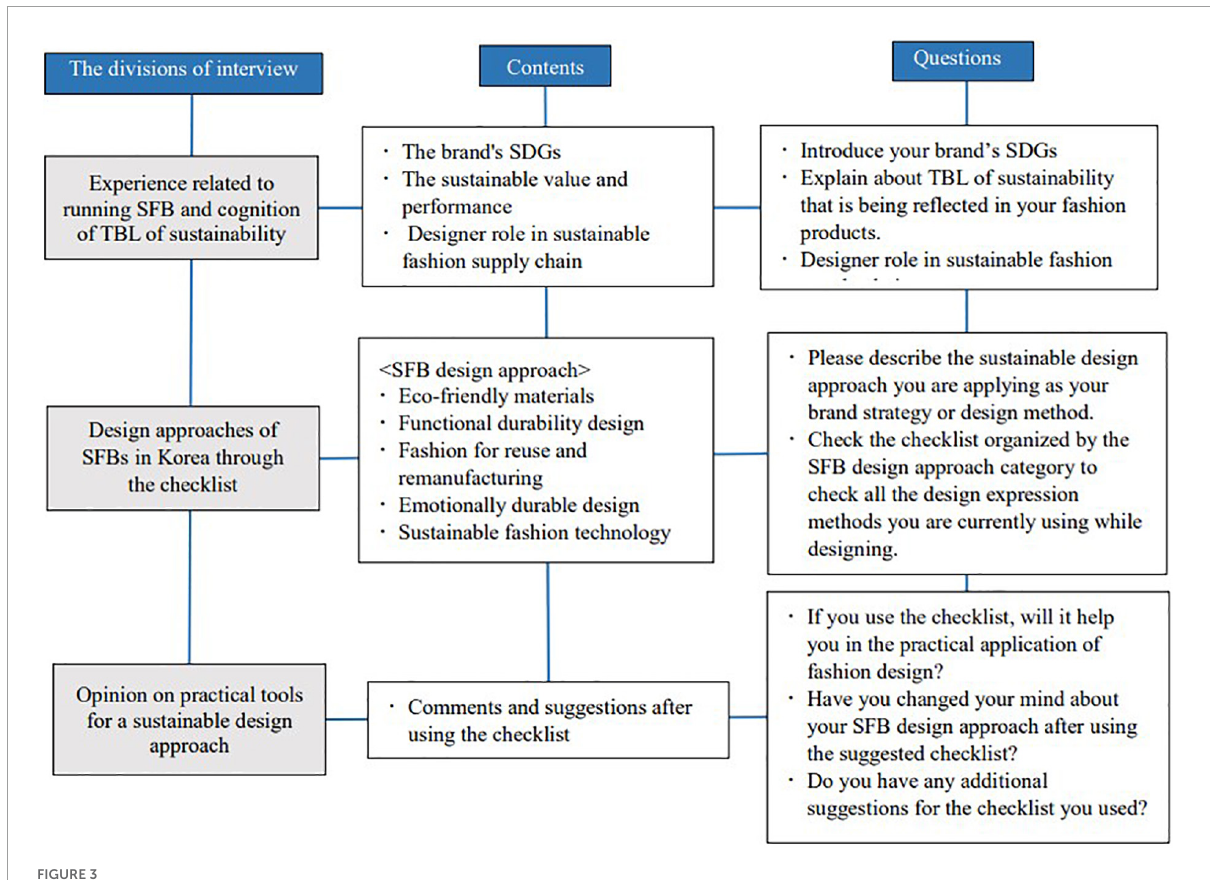
FIGURE3 Interview questions on sustainable fashion brands’ (SFBs) design approach methods.